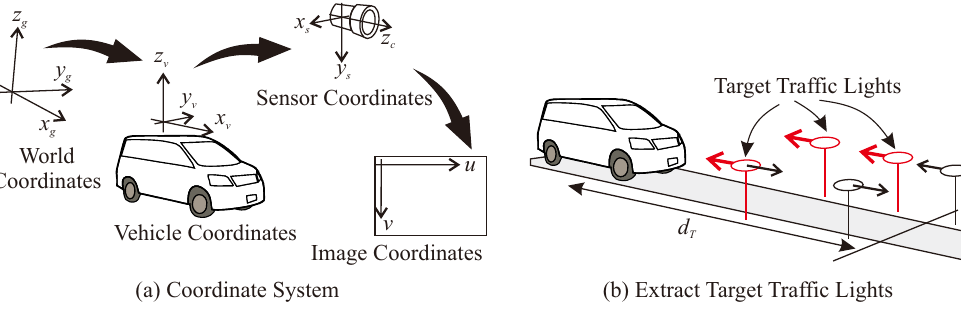
Figure 5. Coordinate systems and traffic light